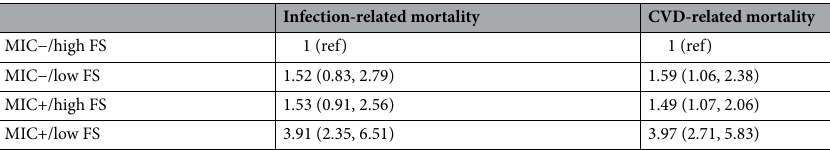
Table 5. Combined effects of MIC and FS status on risk of cause-specific death. The association of MIC and FS status with risk of cause-specific death was evaluated using Cox proportional hazards with models adjusted with same covariates as model 3 in Table 4. Results are shown as hazard ratio (95% confidence interval). Infection related death rate was 1.4/100 patient-years (total of 136 deaths) and CVD-related death rate was 3.1/100 patient-years (total of 301 deaths), respectively. MIC, malnutrition-inflammation-complex; FS, functional